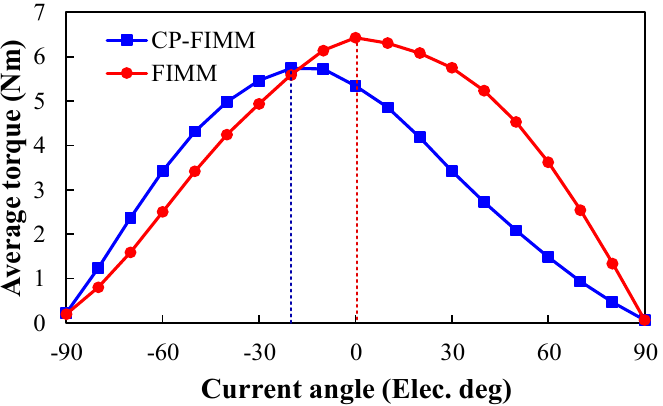
Figure 10. Average torque versus current angle plots of the CP-FIMM and FIMM. Figure 11 shows the cogging torque waveforms of the CF-FIMM and FIMM. Since the rotor iron poles serve as half of the magnetic poles, CP-FIMM shares identical cogging torque period with the FIMM. In addition, the two machines have comparable cogging torque amplitude.